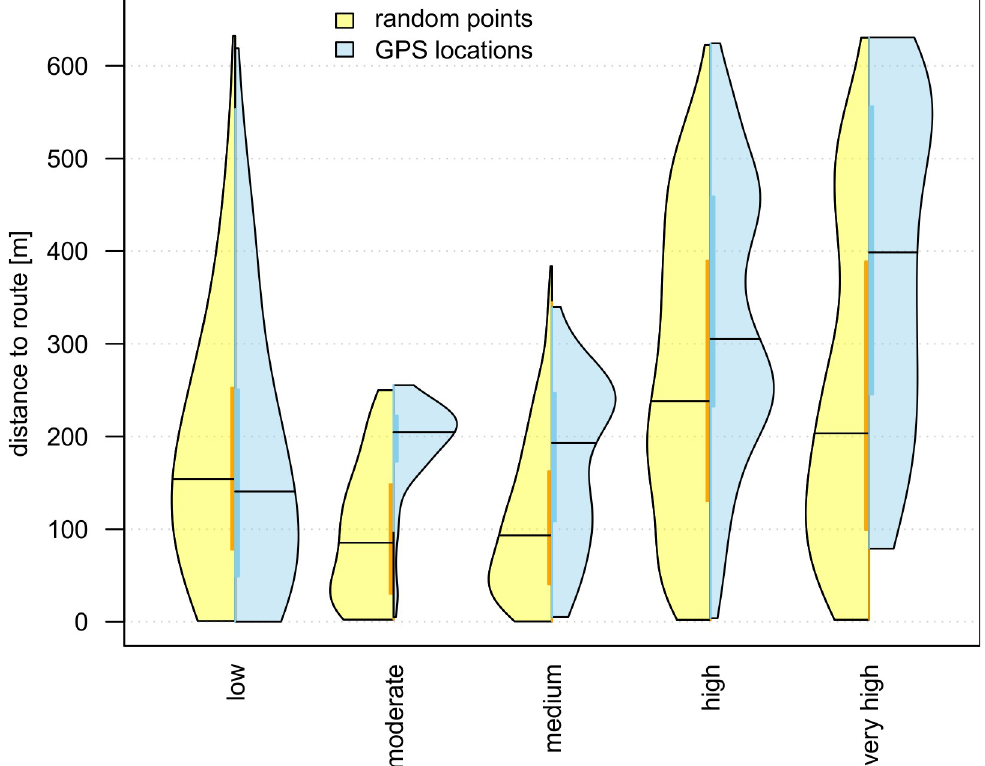
Fig 4. Observed habitat use (GPS locations) versus expected habitat use (random points) in dependence of the intensity of human activity. Distributions of distances towards routes are sorted according to category of visitor frequencies (from low to very high). Mean values are marked by black horizontal lines, quantiles are indicated by thick, coloured vertical bars. Violin bodies show the kernel density distributions of locations and random points over their distances to